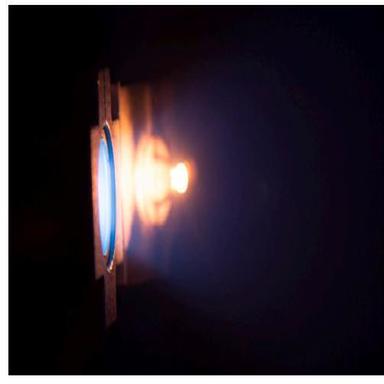
Operation of the Alberich ACFT featuring a thermionic cathode.